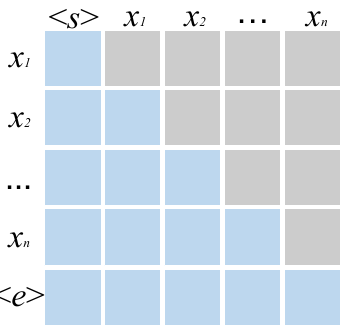
Figure 10. Attention